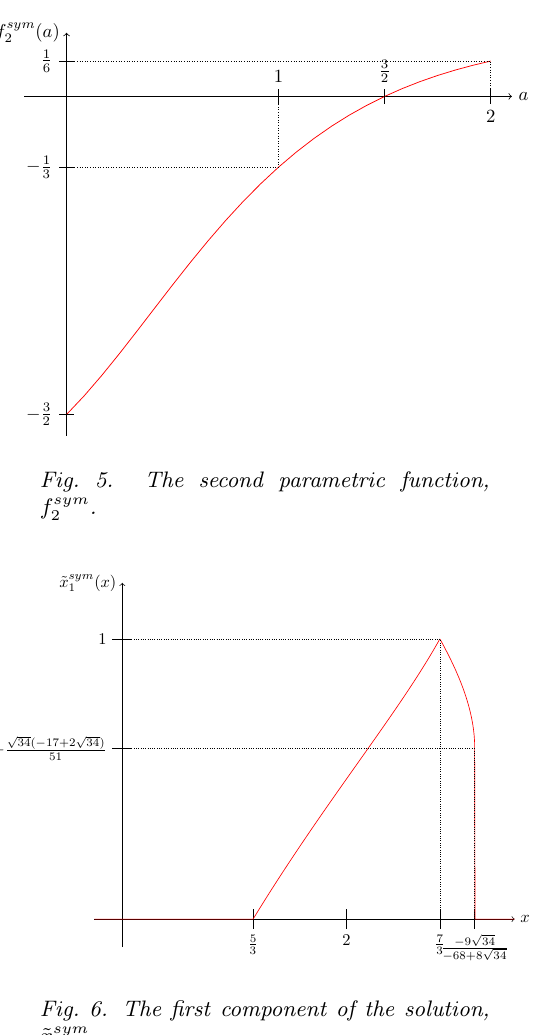
Fig. 6. The first component of the solution, . ˜ x sym 1